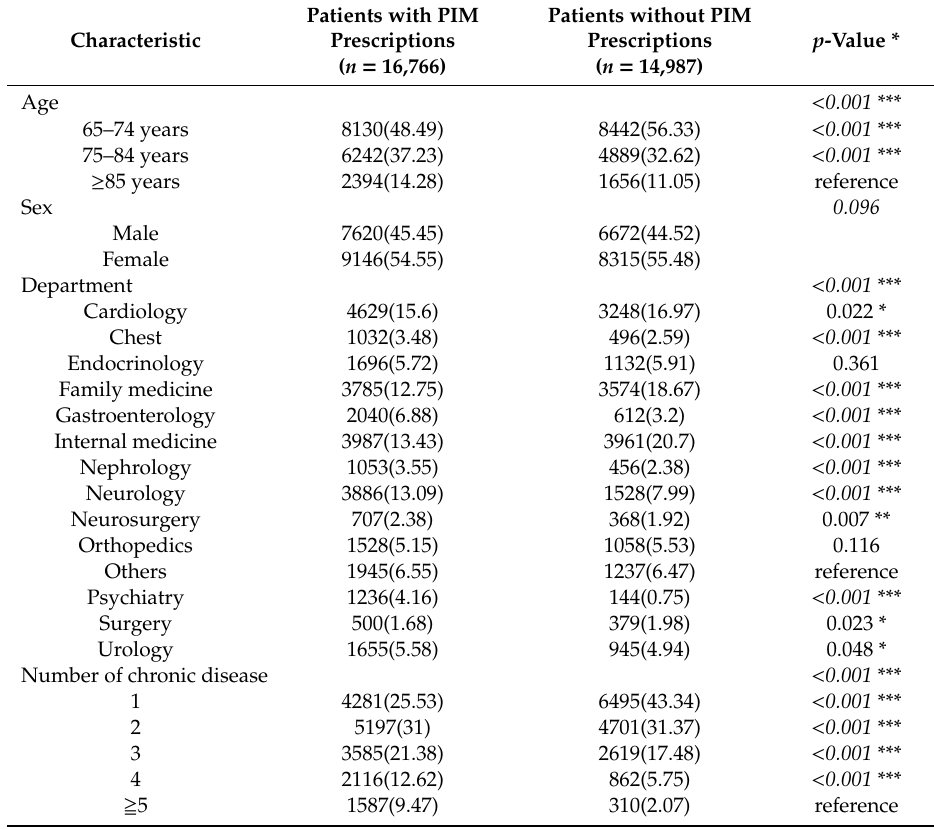
Table 1. Study participants’ demographic and clinical